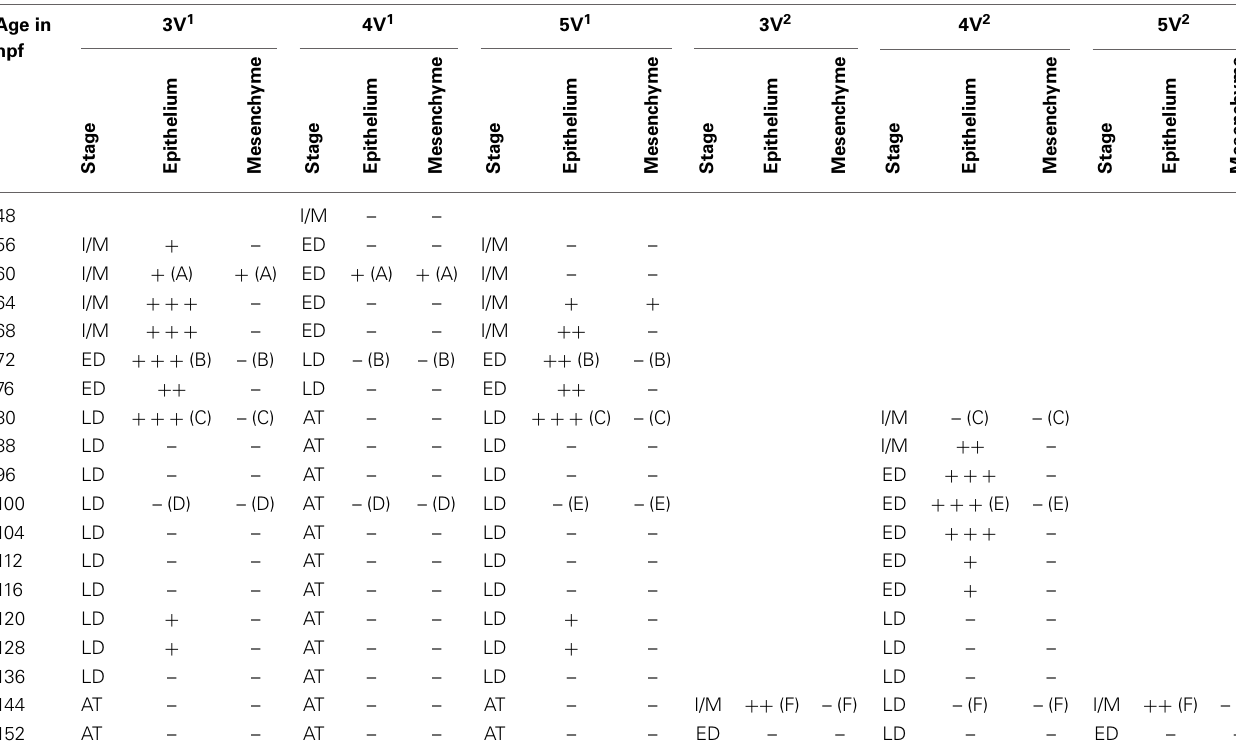
Table 1 | Expression of dkk1 in epithelium and mesenchyme of first-generation teeth (3V 1 , 4V 1 , and 5V 1 ) and their successors (3V 2 , 4V 2 , and 5V 2 ) between 48 and